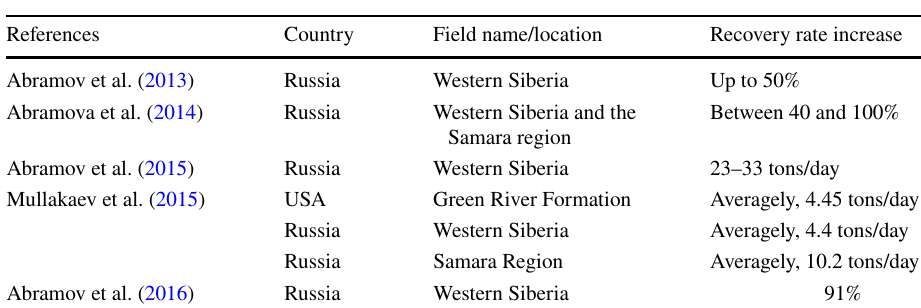
Table 4 Recent application of ultrasonic technique in oil